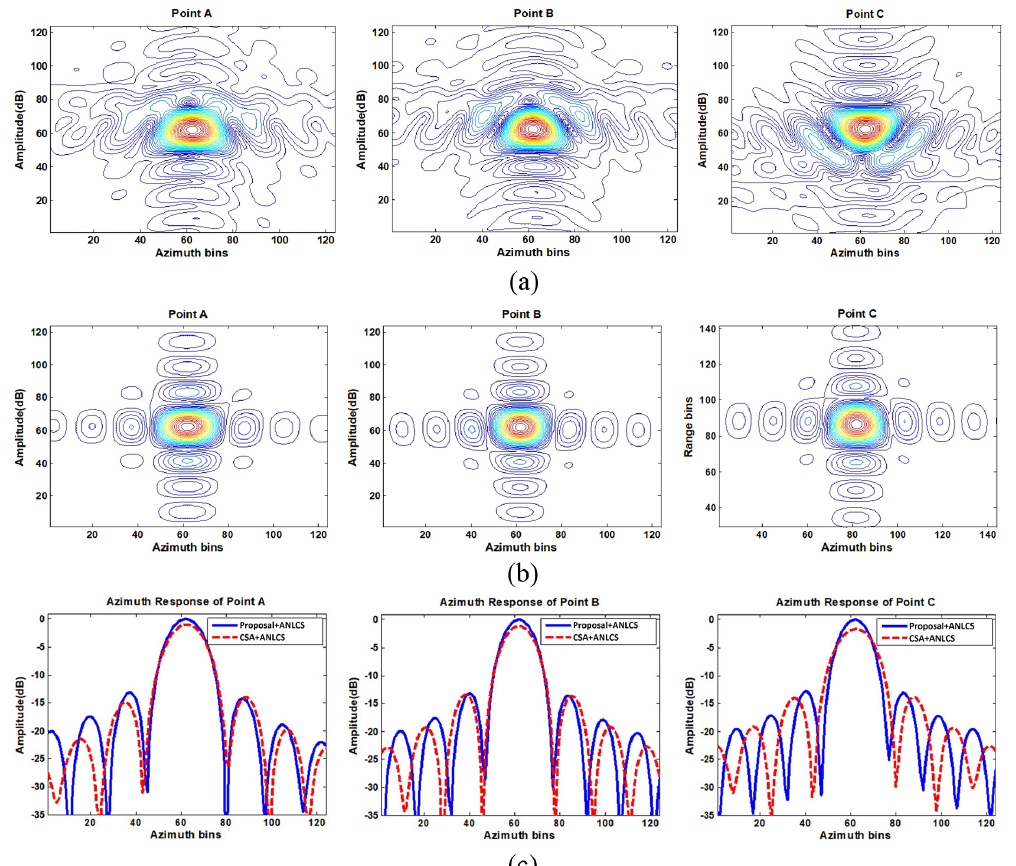
Figure 6. Azimuth impulse response comparisons. ( a ) 2D impulse responses of points A, B, and C using CSA+ANLCS; ( b ) 2D impulse response of A, B, and C using the proposed algorithm+ANLCS; ( c ) Comparison of azimuth impulse responses of points A, B, and